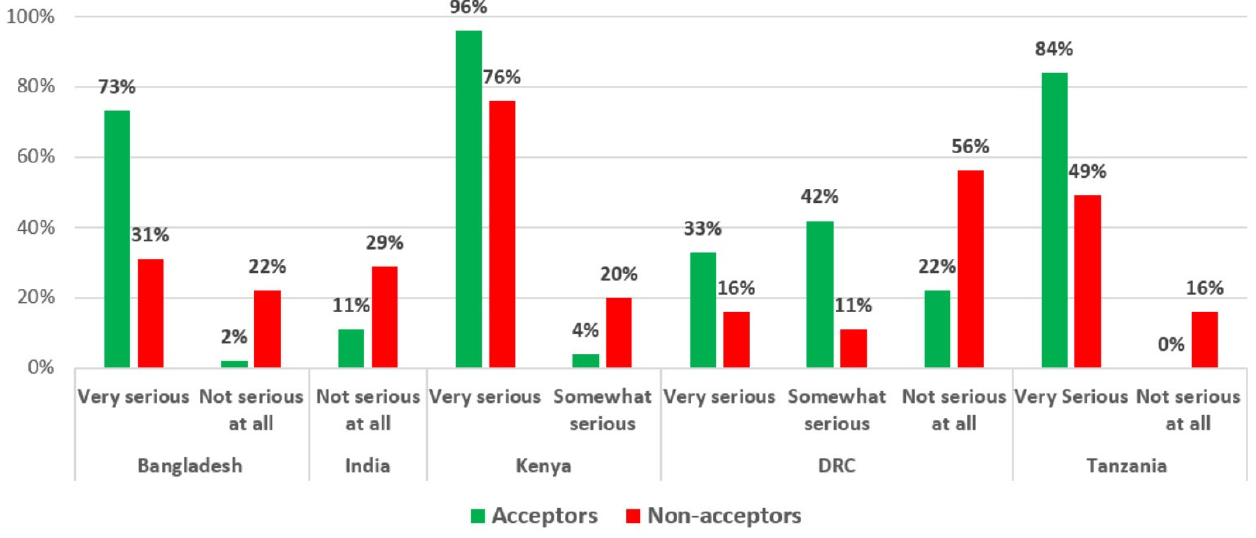
Figure 8. Perceived severity of COVID-19 by country.